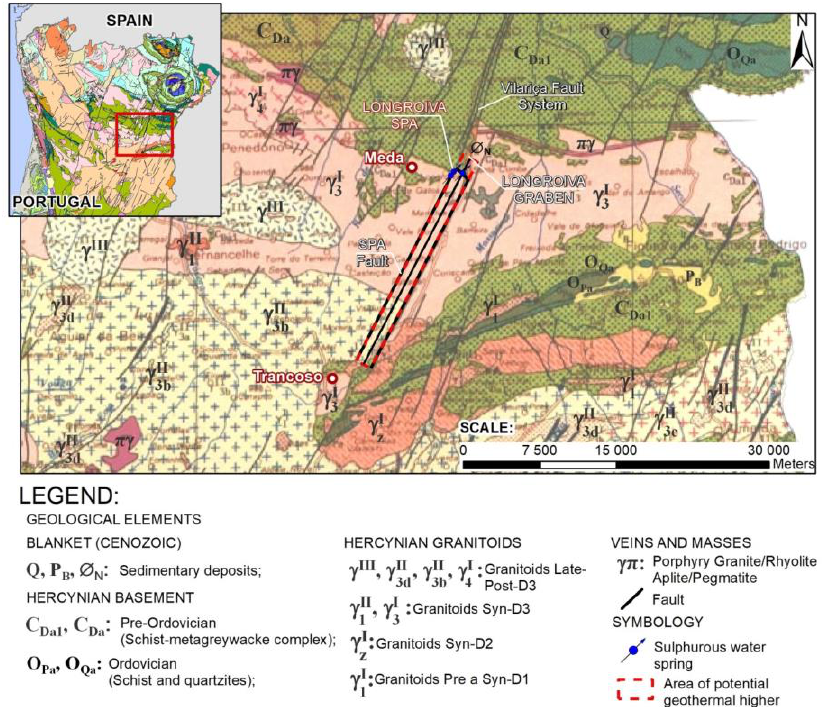
Figure 5. Longroiva geothermal area: geology, tectonics, and hydrothermal features. Adapted from SGP and LNEG. Reproduced with permission from [44,45], Geological Services of Portugal. Geological Services of Portugal, 1992.